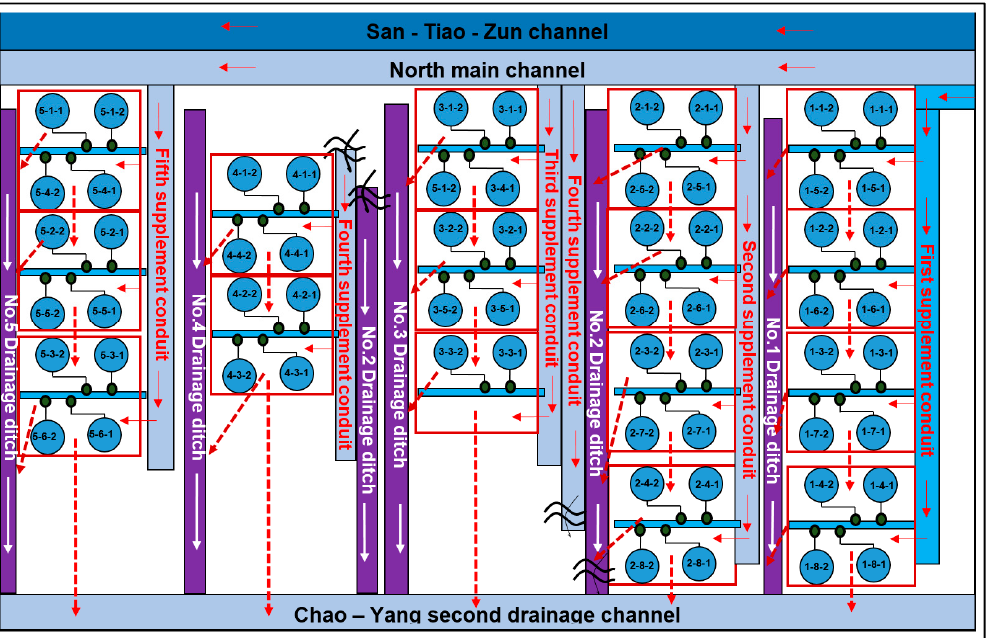
Figure 10. Flow direction of each block and sub-block in the study region.